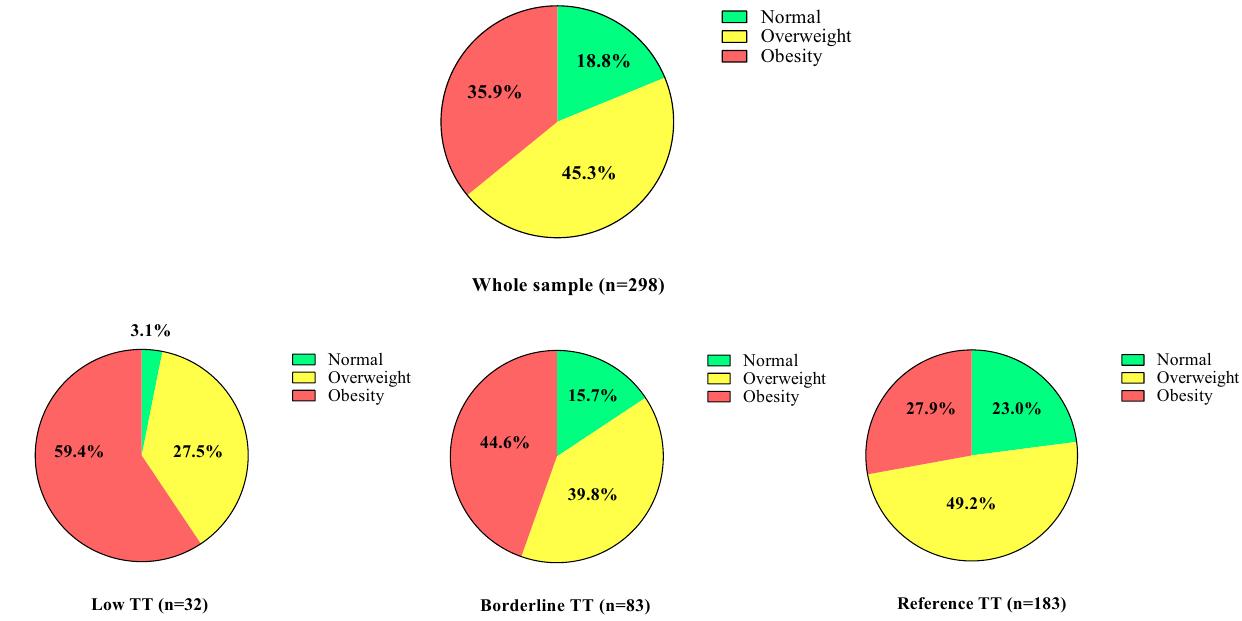
Figure 1. Distribution of firefighters of different BMI categories among total testosterone groups, Low TT (< 264 ng/dL), Borderline TT (264–399 ng/dL), and Reference TT (400–916 ng/dL).